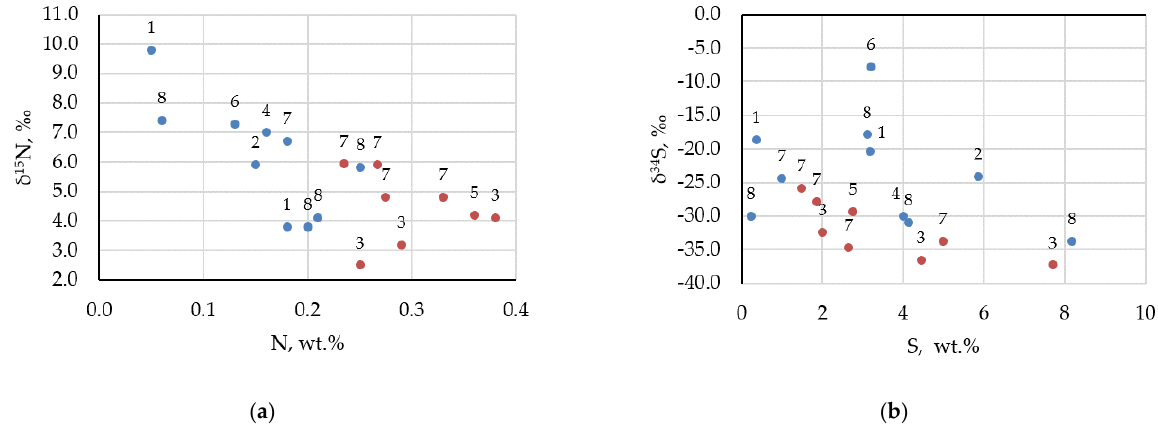
Figure 11. ( a ) Cross-plot of the elemental and isotopic composition of nitrogen. ( b ) Cross-plot of the elemental and isotopic composition of sulfur. The two series of samples represent rocks with C org < 5 wt.% (blue markers) and C org > 5 wt.% (red markers), numbers correspond to geochemical members.